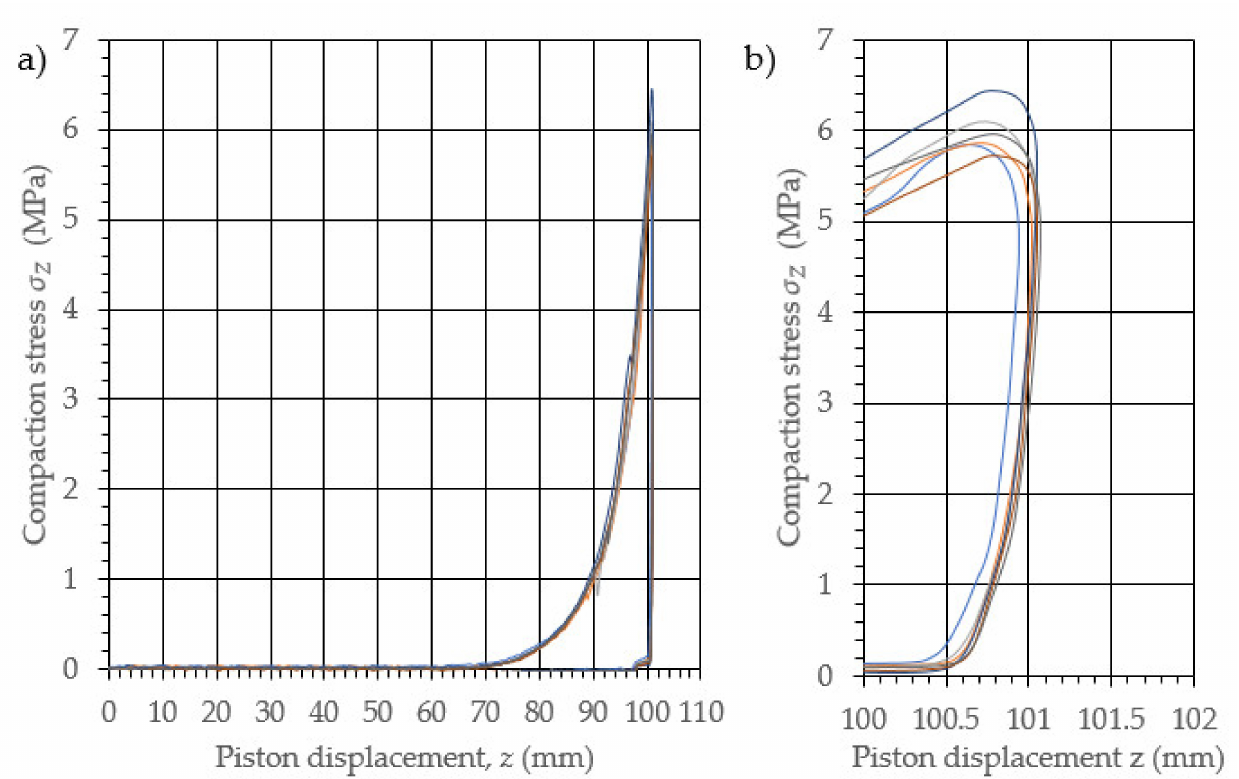
Figure 6. Characteristic curves for the compression with relaxation of dry ice with a final density of 1321.3 kg/m 3 . ( a ): The overall course of the characteristics; ( b ): an enlarged relaxation section of the compacted material.